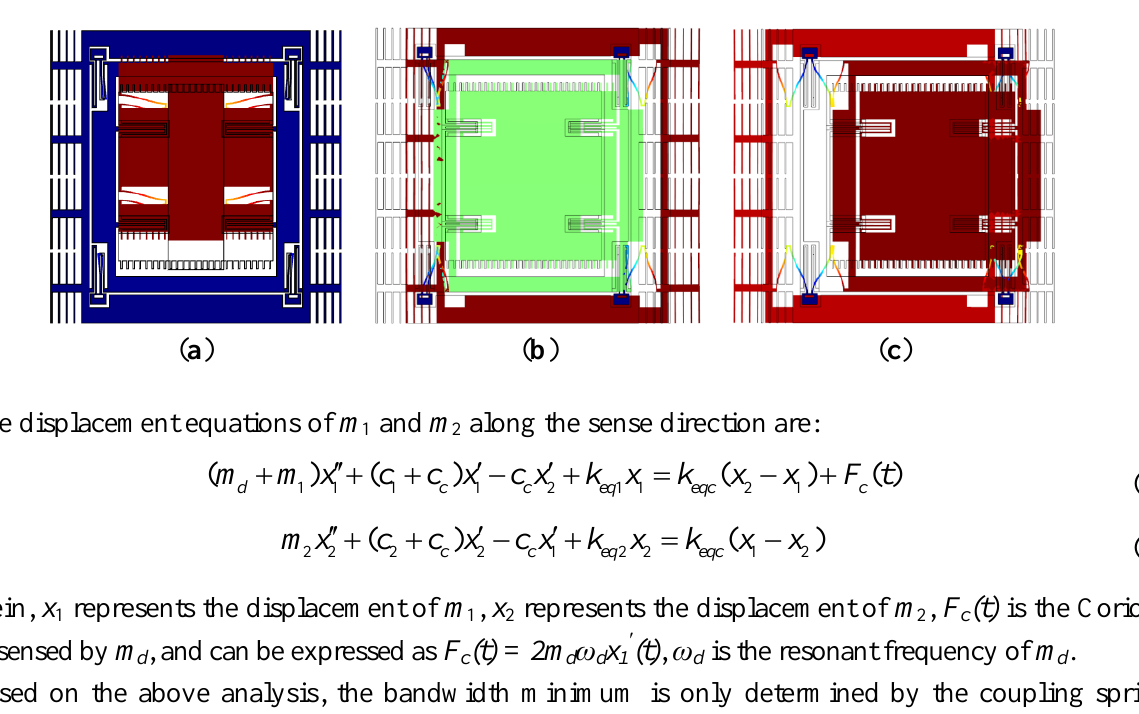
Figure 4. Vibration modes of the designed MEMS gyroscope. ( a ) Drive mode; ( b ) In-phase sense mode; ( c ) Anti-phase sense